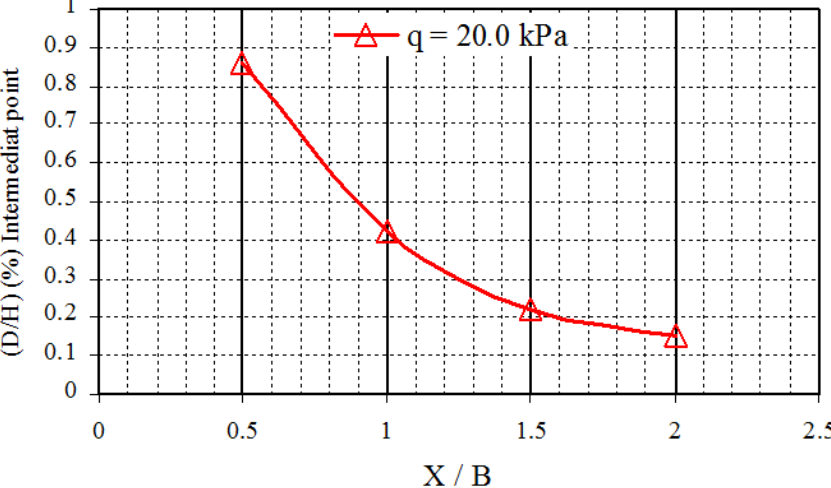
Figure 26. Influence of footing position on the mid-height slope horizontal movement.